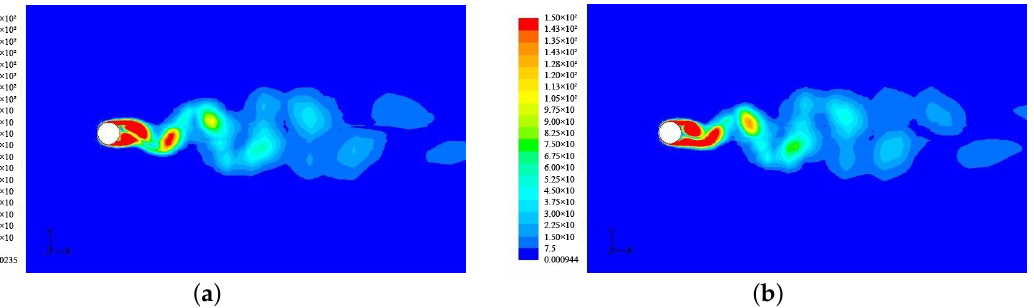
Figure 10. Cloud map of vorticity at 2 m underwater depth at different times: ( a ) at the moment of 60 s, the vorticity cloud map of 2 m water depth; ( b ) at the moment of 66 s, the vorticity cloud map of 2 m water depth.